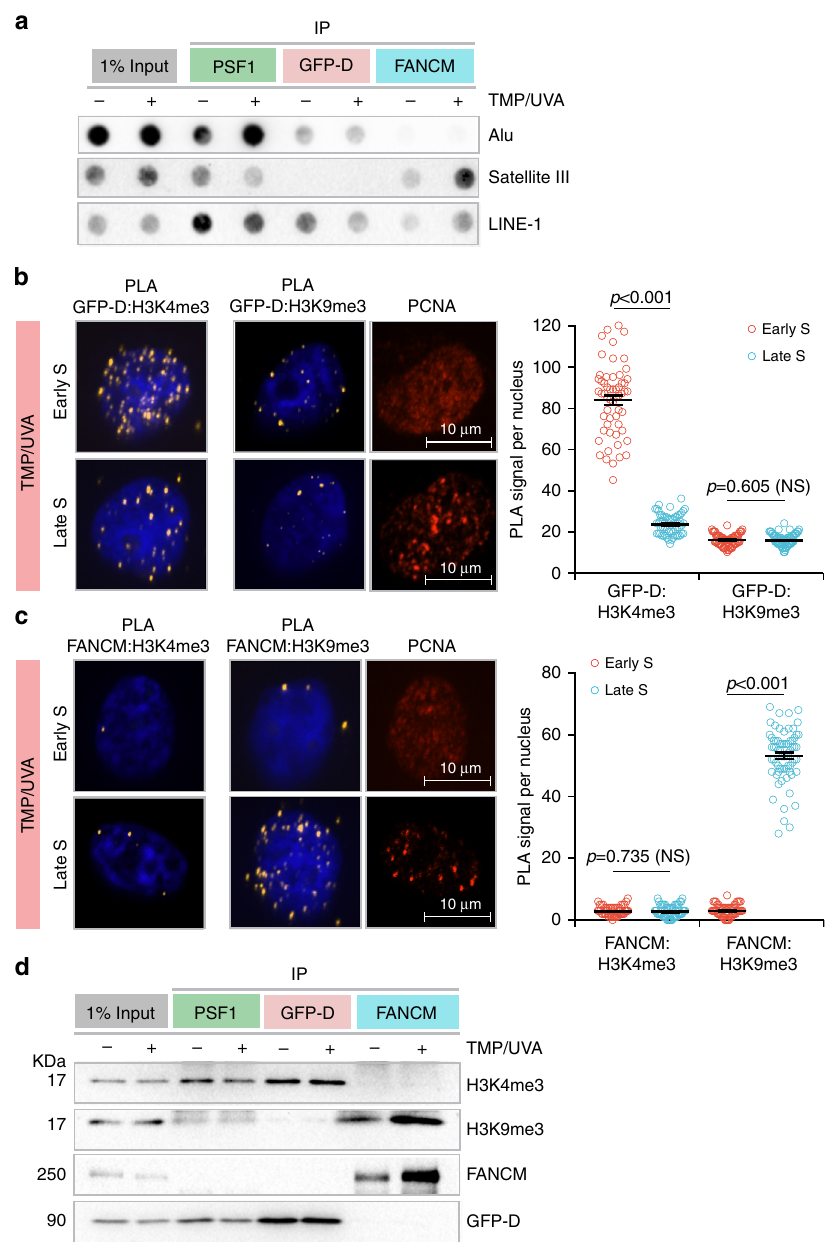
Fig. 4 Relationship of DONSON and FANCM to replication timing and chromatin domain. Cells were treated with either UVA or TMP/UVA. a Sequential IP demonstrates association of early-replicating Alu sequences with DONSON and late-replicating Satellite 3 sequences with FANCM. LINE-1 elements replicate throughout the S phase and are found in all fractions. Representative blot ( n = 3). b DONSON interaction with the H3K4me3 euchromatin mark is more frequent in early S phase cells than in late S phase, while there is little interaction with the H3K9me3 heterochromatin mark in either stage.